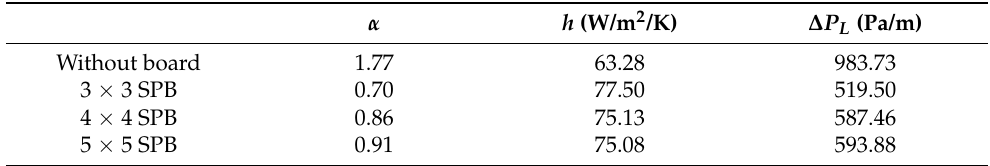
Table 3. Thermo-hydraulic performance of DF-PCHE channels with four types of SPBs using ∆ L = 150 mm cross-section as inlet.